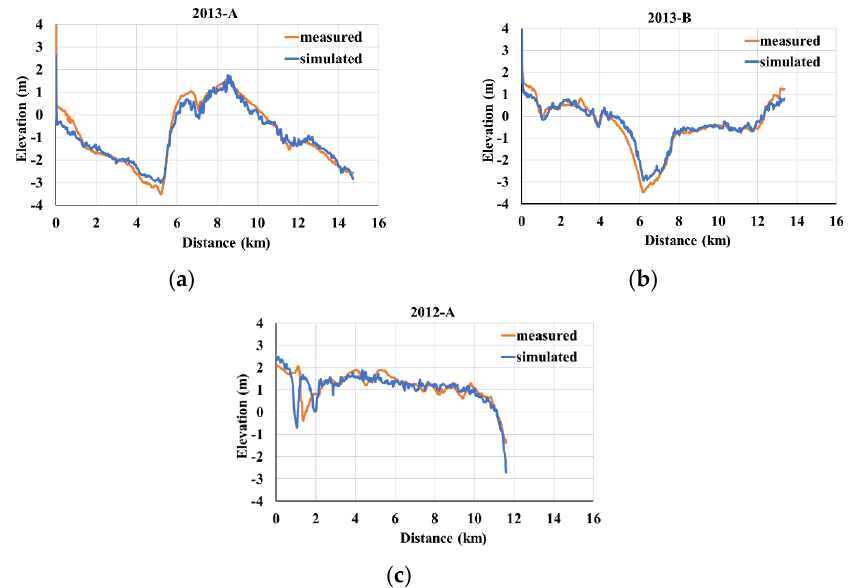
Figure 8. Comparative maps between the simulated and measured data: ( a ) Section 2013-A; ( b ) section 2013-B; ( c ) section 2012-A.